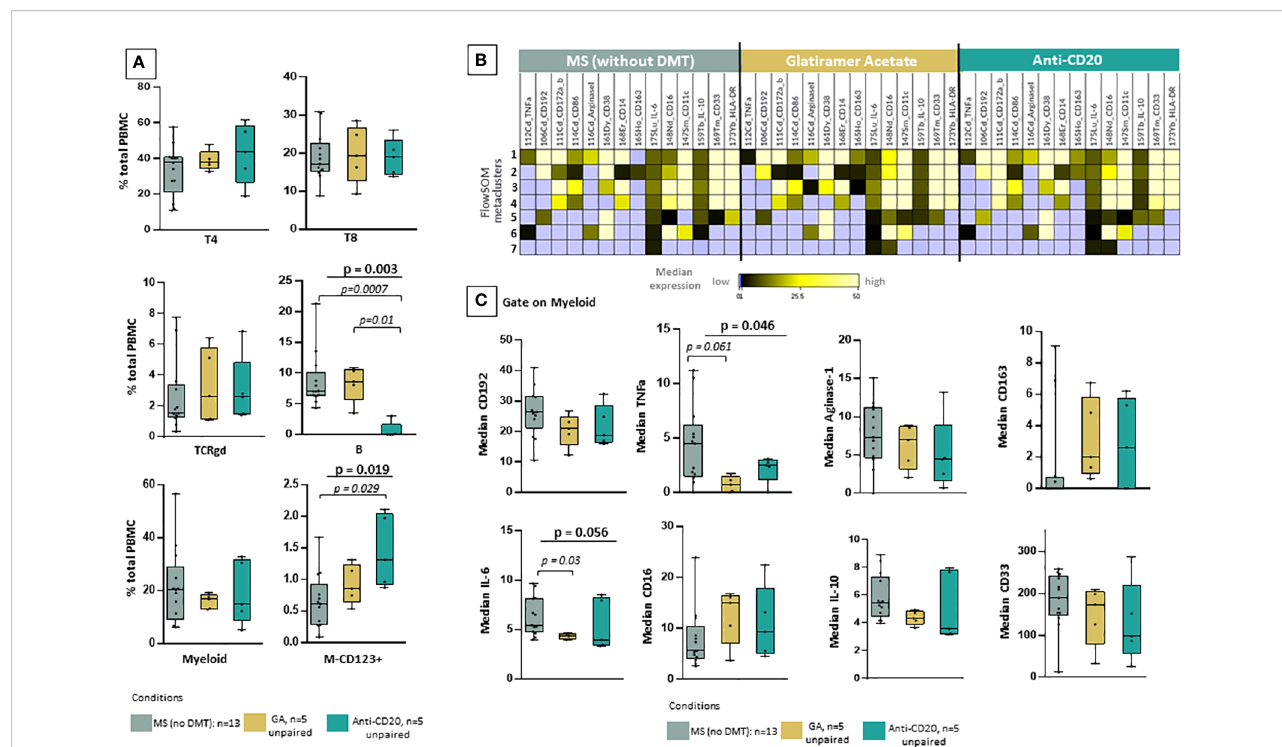
FIGURE 5 Reshaping of myeloid signature population under glatiramer acetate and anti-CD20 therapy. (A) Box plots showing the frequency (expressed as % of CD45+ cells) of each major cell-lineage cluster in peripheral blood mononuclear cells of MS patients divided in three groups; those under no anti-DMT therapy (n=13, both TMS and RRMS are included, PPMS excluded), those under anti-CD20 treatments (n=5, both TMS and RRMS are included) and those under glatiramer acetate (n=5, both TMS and RRMS are included). (B) FlowSOM identi fi ed metaclusters in myeloid cells and heatmap showing, for each of the metaclusters generated, in the three groups of interest (MS under no DMT, MS under glatiramer acetate, MS under anti-CD20), the average intensity of each myeloid cell related marker (stage or activation marker). Higher average expression of each marker is indicated with a green-yellow color, and lower expression in black. Absence of expression is depicted with blue. (C) Box plots showing the median expression of each marker on total myeloid cells in peripheral blood mononuclear cells of patient subgroups (MS under no DMT, MS under glatiramer acetate, MS under anti-CD20). (D) tSNE plots of one TMS patient during relapse and after anti-CD20 treatment. The expression levels of indicative markers are shown in plots. p < 0.05 was considered signi fi cant, non-parametric Kruskal Wallis test with correction for multiple comparisons (FDR) was applied). FDR, false discovery rate; TMS, Tumefactive Multiple Sclerosis; DMT, disease modifying therapy; FlowSOM, Flow Self-Organizing Map; CCR2 or CD192, C-C chemokine receptor type 2TNF- a , tumor necrosis factor alpha, IL-10; Interleukin 10, IL-6; Interleukin